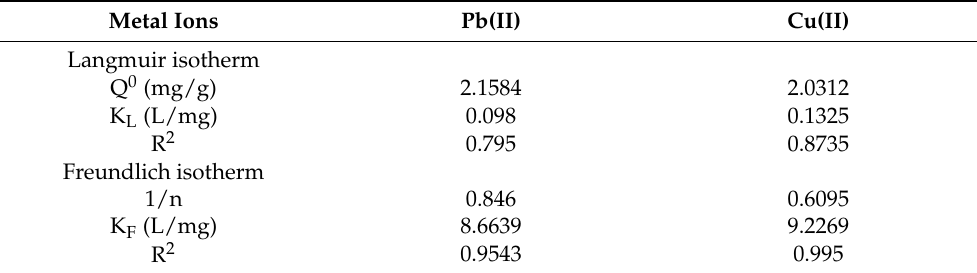
Table 2. The isotherm parameters for the adsorption of Pb(II) and Cu(II) ions by